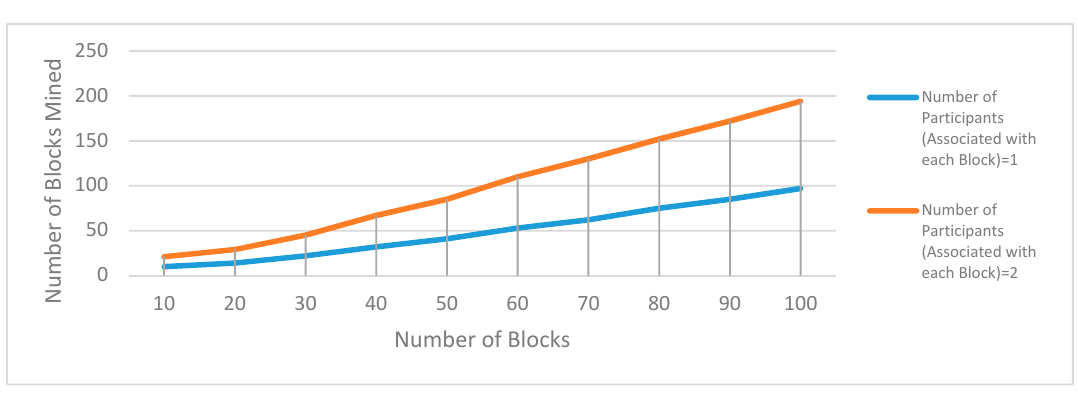
Figure 30. Analysis of the number of blocks mined as the number of participants associated with those blocks increases with time.